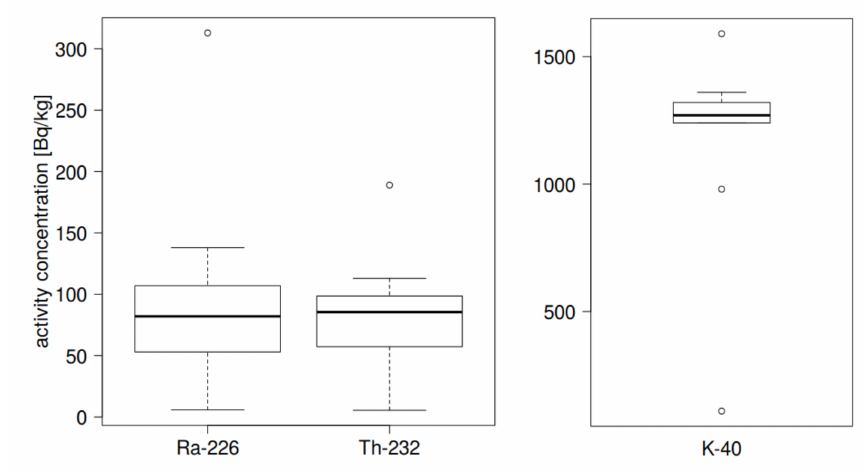
Figure 13. Box-whiskers charts for specific activity concentration of radium and thorium. Outliers that should be rejected in further analysis are clearly